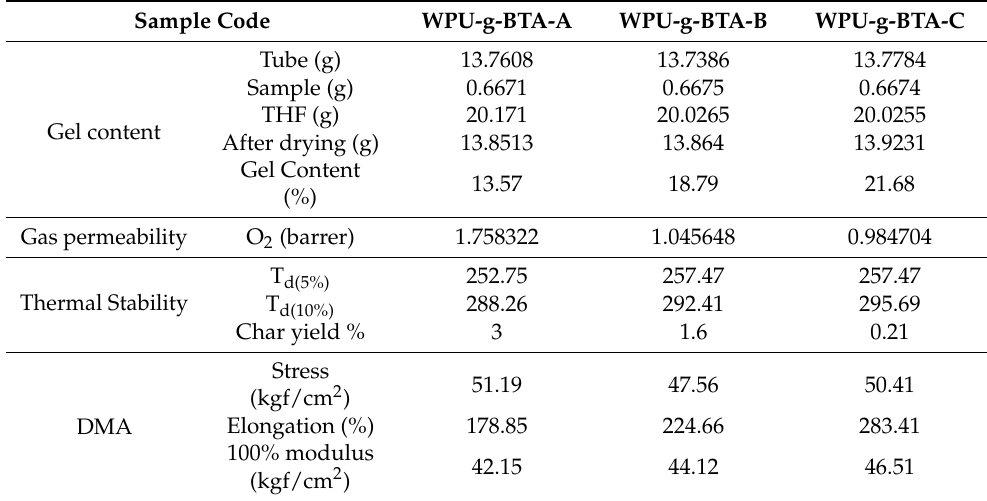
Table 1. Gel content, O 2 permeability, and thermal stability measured from TGA and DMA results of WPU-g-BTA coatings.